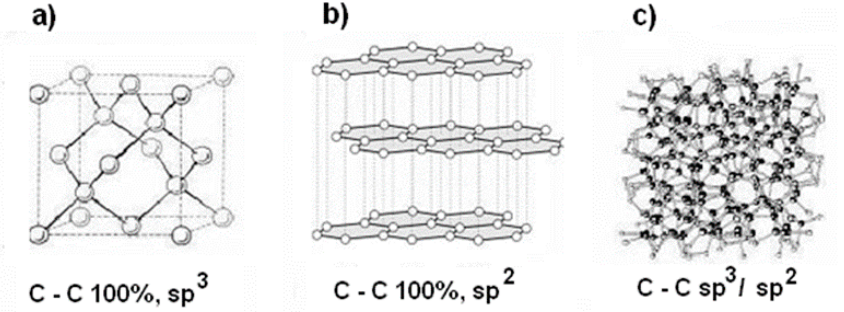
Figure 1. Models of the crystal structure; ( a ) diamond, ( b ) graphite, and ( c ) diamond-like carbon (DLC) coating.